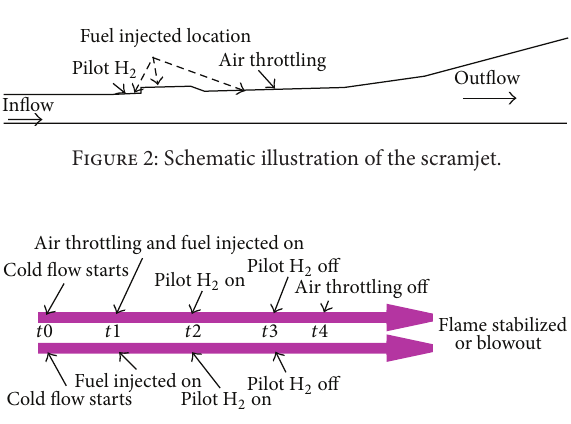
Figure 3: A schematic of the operation sequence of the system with and without air throttling.